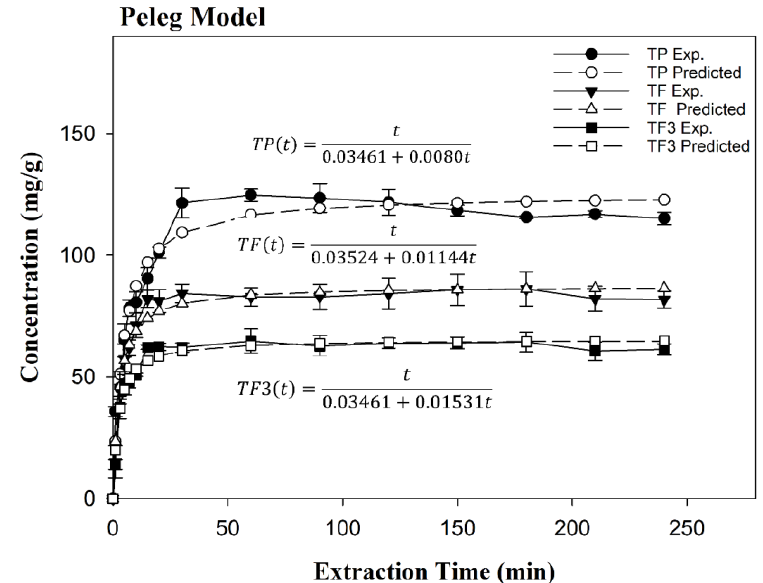
Figure 4. Experimental and calculated extraction curves for a total polyphenol (TP), total flavonoids (TF), and flavan-3-ols content. E (TF3). Extraction rate constant based on Peleg model and solid–liquid extraction at optimal conditions.